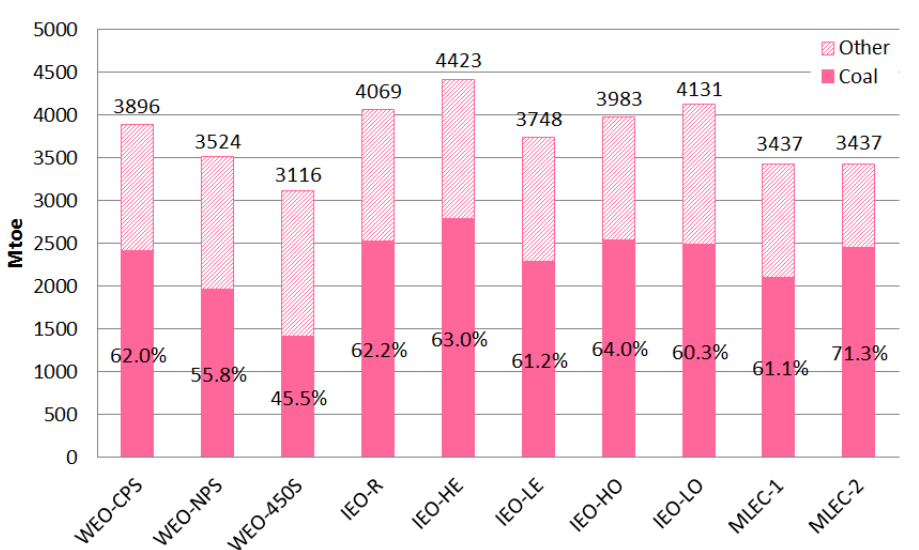
Figure 12. Coal demand projections in different scenarios,